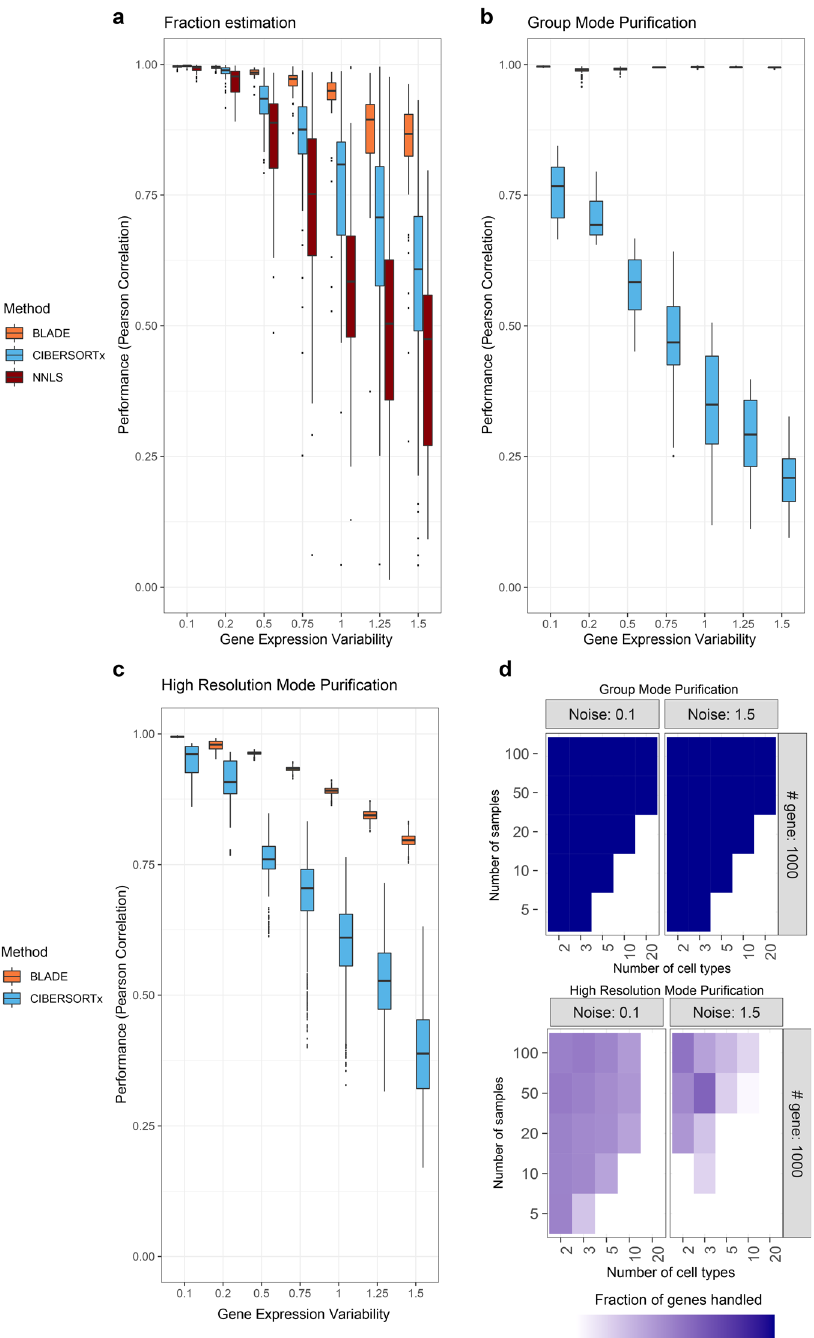
Fig. 4 Performance evaluation BLADE using simulation data with diverse settings. a Performances (Pearson correlation coef fi cient; y -axis) of BLADE (orange), CIBERSORTx (blue), and NNLS (dark red) to predict the cellular fraction of a subset of simulation data with ten cell types, 1000 genes, and various variability levels (standard deviation of 0.1 – 1.5; x -axis; n = 50 per variability level; fi ve independent data set with ten cell types each). The standard boxplot notation was used (lower/upper hinges — fi rst/third quartiles; whiskers extend from the hinges to the largest/lowest values no further than 1.5 * inter-quartile ranges). b , c Performances (Pearson correlation coef fi cient; y -axis) of BLADE (orange) and CIBERSORTx (blue) to predict gene expression pro fi les per cell type for all samples jointly (group mode; b ) and for each sample separately (high-resolution mode; c ) using the same simulation data ( n = 50 per variability level; fi ve independent data set with ten cell types each). The standard boxplot notation was used. d Fractions of puri fi ed genes in the simulation data with two extreme levels of gene expression variability (left and right panels) by CIBERSORTx in group mode (top) and high-resolution mode (bottom). x - and y -axis represent the number of cell types and samples in the simulation data,